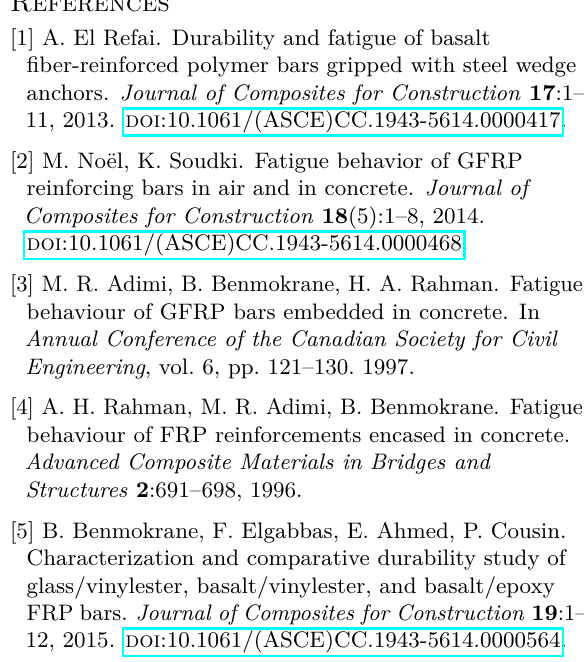
and FAST-J-18-5224 “Interlaminar shear test of FRP bars for quick and effective evaluation of product quality and determination of degradation